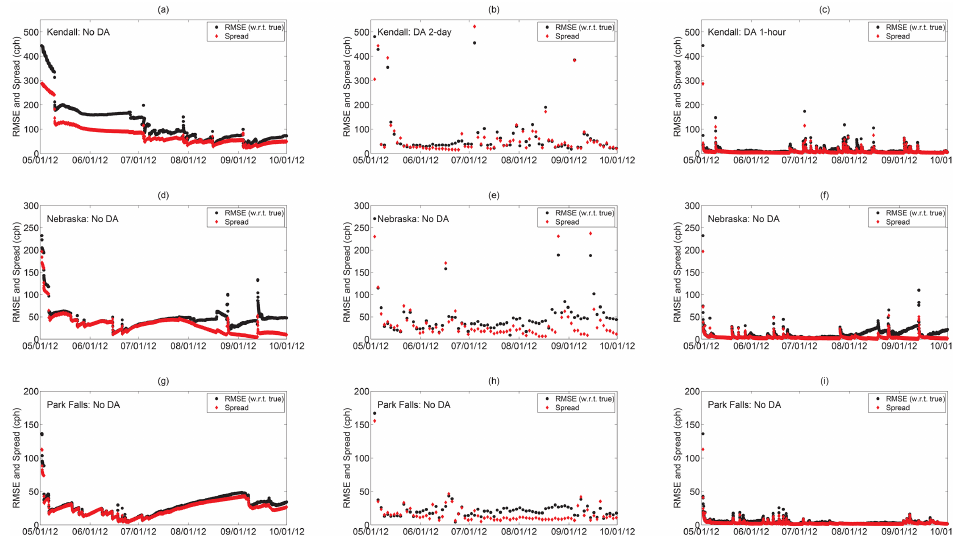
Figure 5. Root-Mean-Squared Error (RMSE) calculated for the ensemble mean relative to the “true” observations (black circles) in compar- ison to the ensemble spread (red diamonds). The ensemble mean of the prior distribution is used for all ensemble